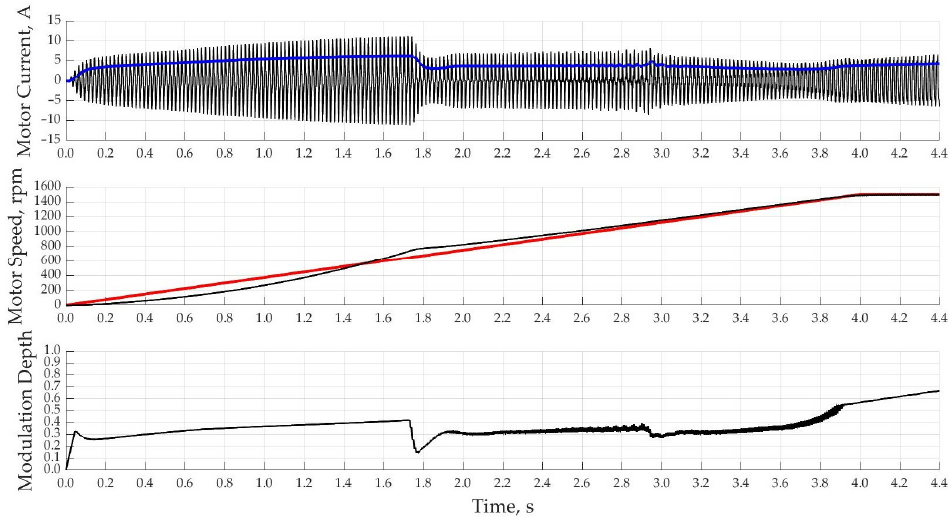
Figure 16. Starting current, motor speed and modulation depth for case of PI-controller with double- loop CS of current and speed of IM with linear increase in speed by reference.